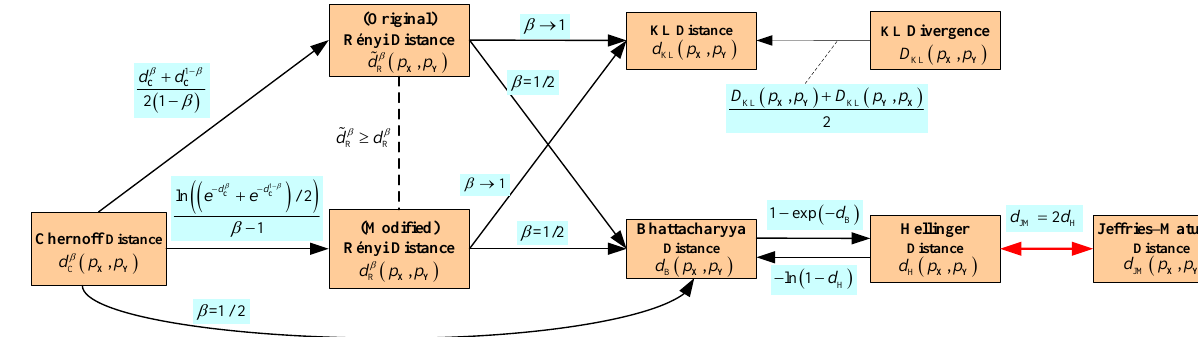
Figure 6. Relations between some typical stochastic distances. p and p In Table 5, X Y i.e., the PDFs of two sets of PolSAR image data